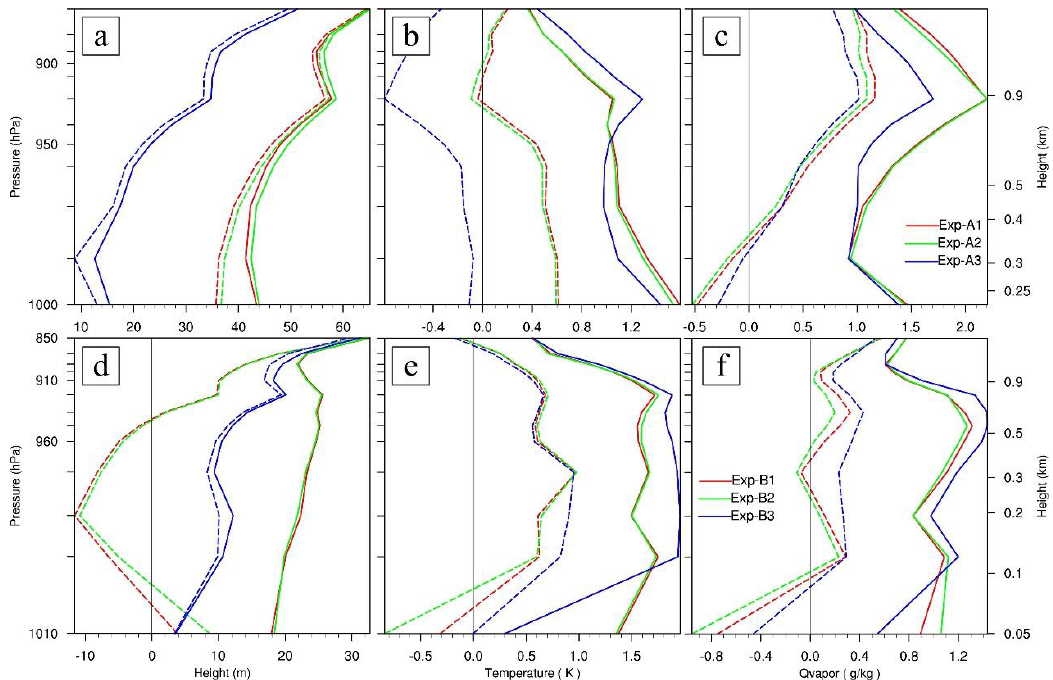
Figure 6. Vertical profiles of the root-mean-square errors (RMSEs) (solid lines) and biases (dashed lines) between the initial analysis and the radiosonde observations of geopotential height ( a , d ), temperature ( b , e ), and mixing ratio ( c , f ). The upper and lower panels are for the cases C-09 and C-14, respectively.